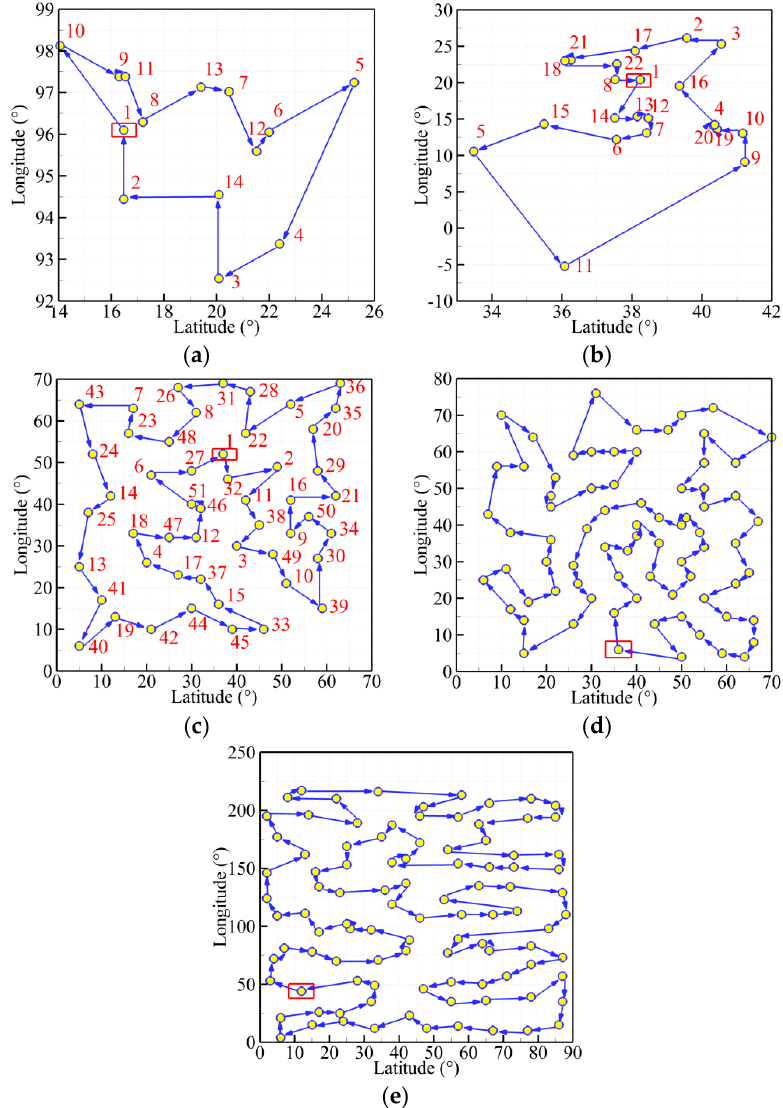
Figure 10. Best routes of the five TSPLIB (library of sample instances for traveling salesman problem) examples: ( a ) burma14; ( b ) ulysses22; ( c ) eil51; ( d ) eil76; ( e ) rat99. examples: ( a ) burma14; ( b ) ulysses22; ( c ) eil51; ( d ) eil76; ( e )